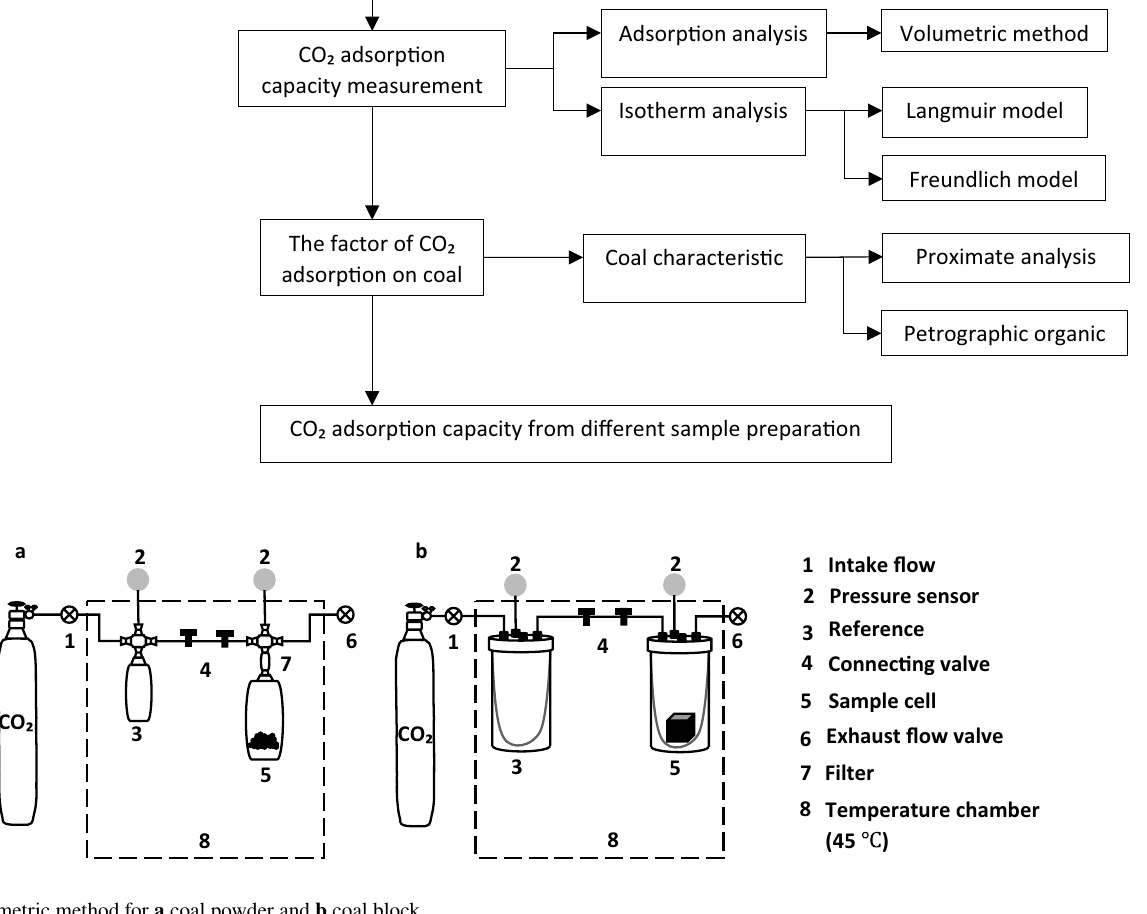
Fig. 5 Volumetric method for a coal powder and b coal